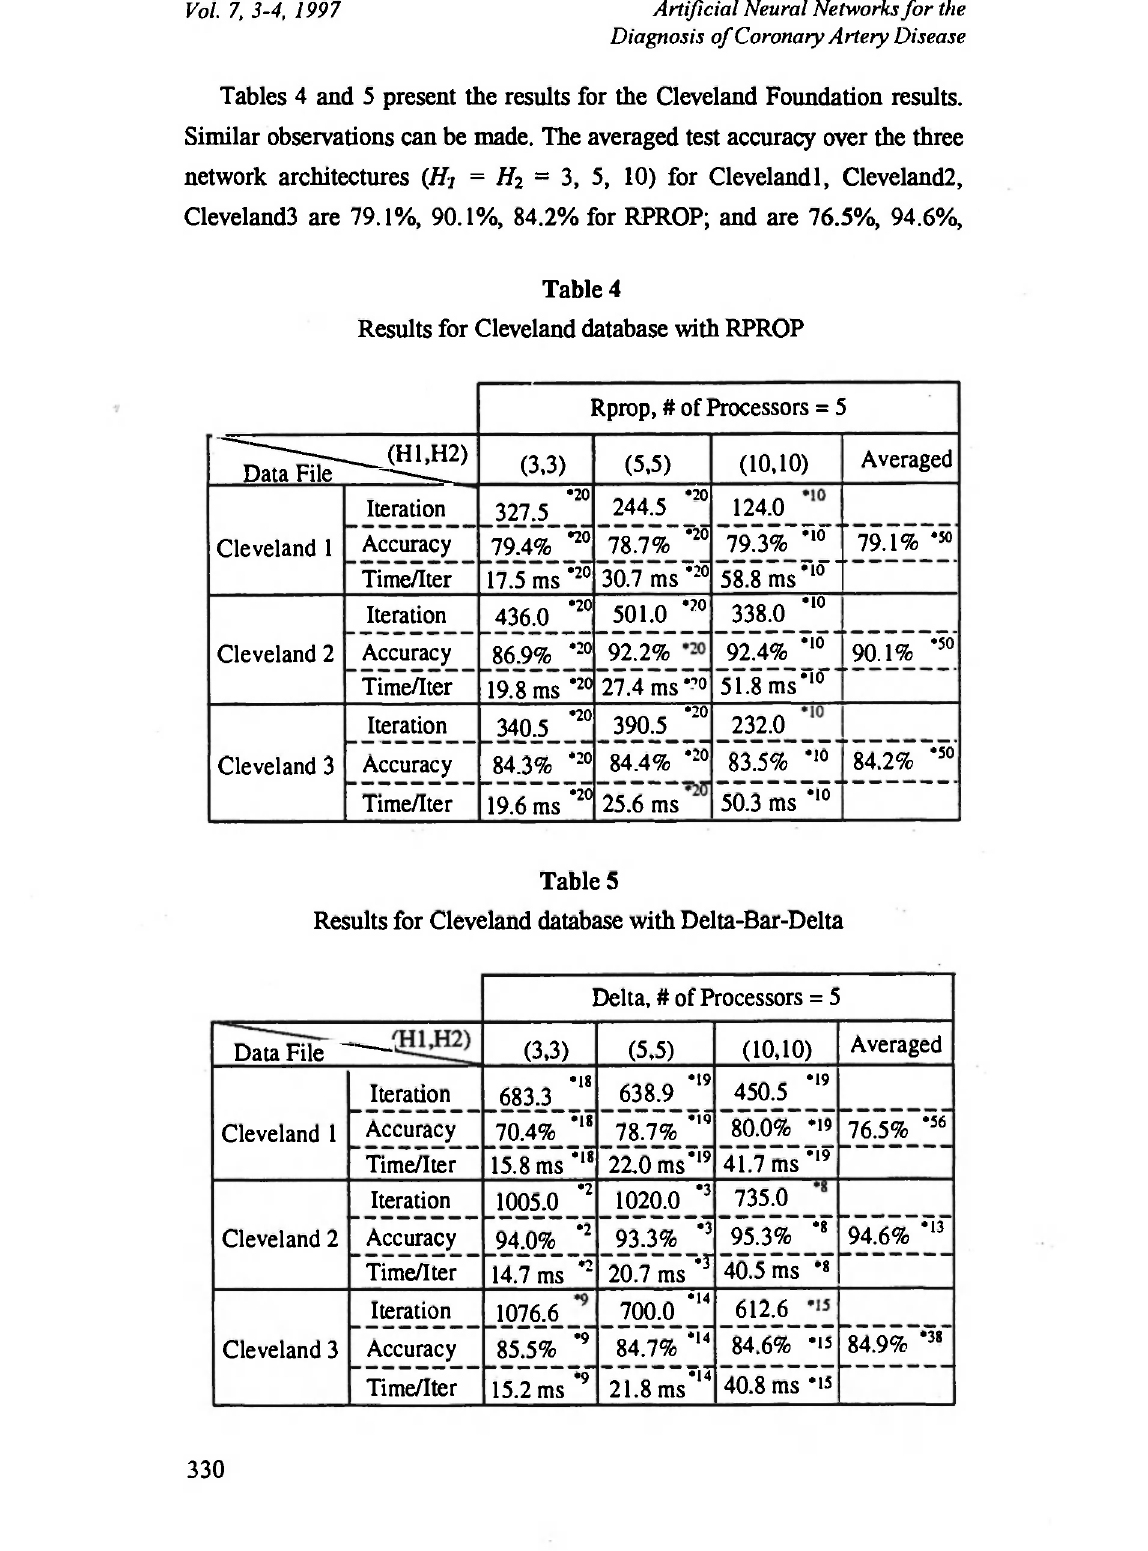
Results for Cleveland database with Delta-Bar-Delta Delta, # of Processors =